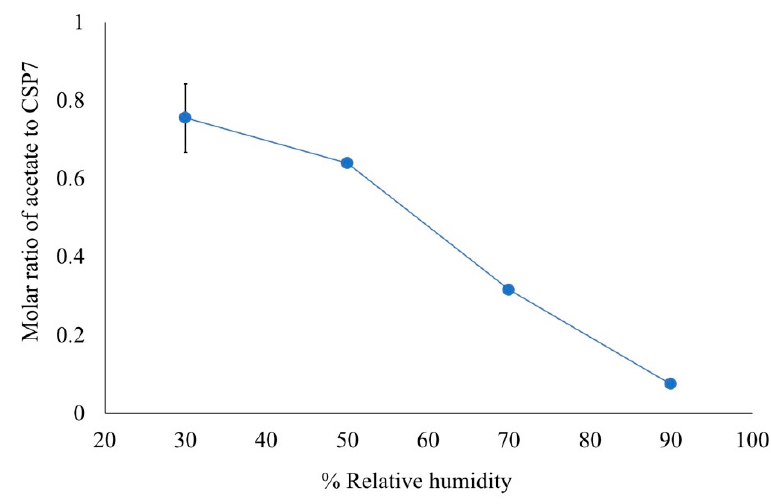
Figure 5. Molar ratio of acetate to CSP7 in bulk material after exposure to different humidity levels.